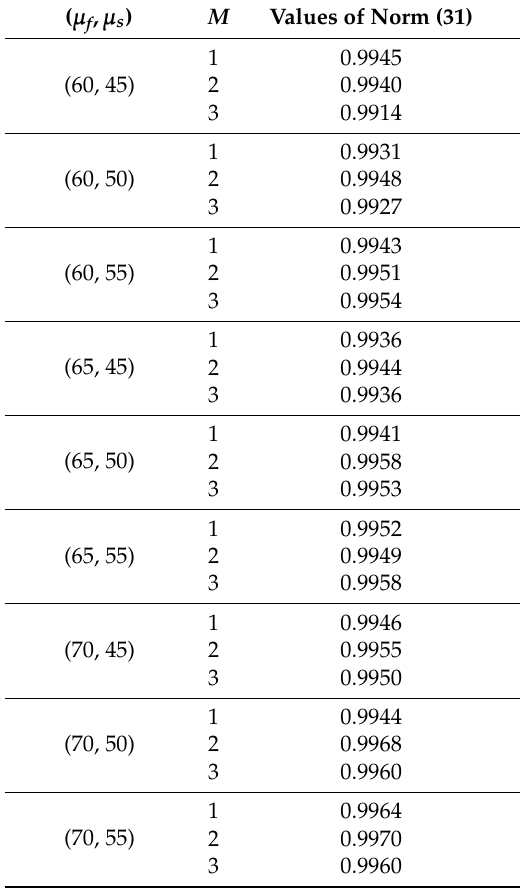
Table 1. Accuracy of the developed algorithm for calculation of steady-state probabilities. Case of fixed values of intensities of Markov Modulated Poisson Process (MMPP)